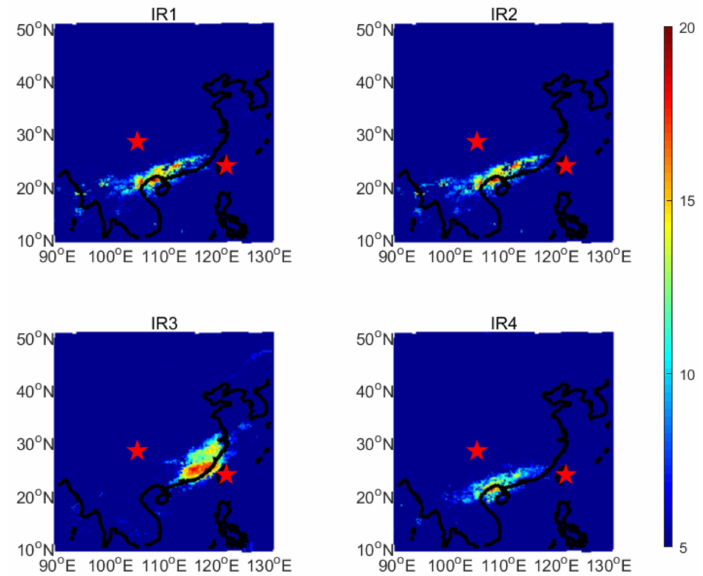
Figure 14. Power spectrum images on 9 December 2018.